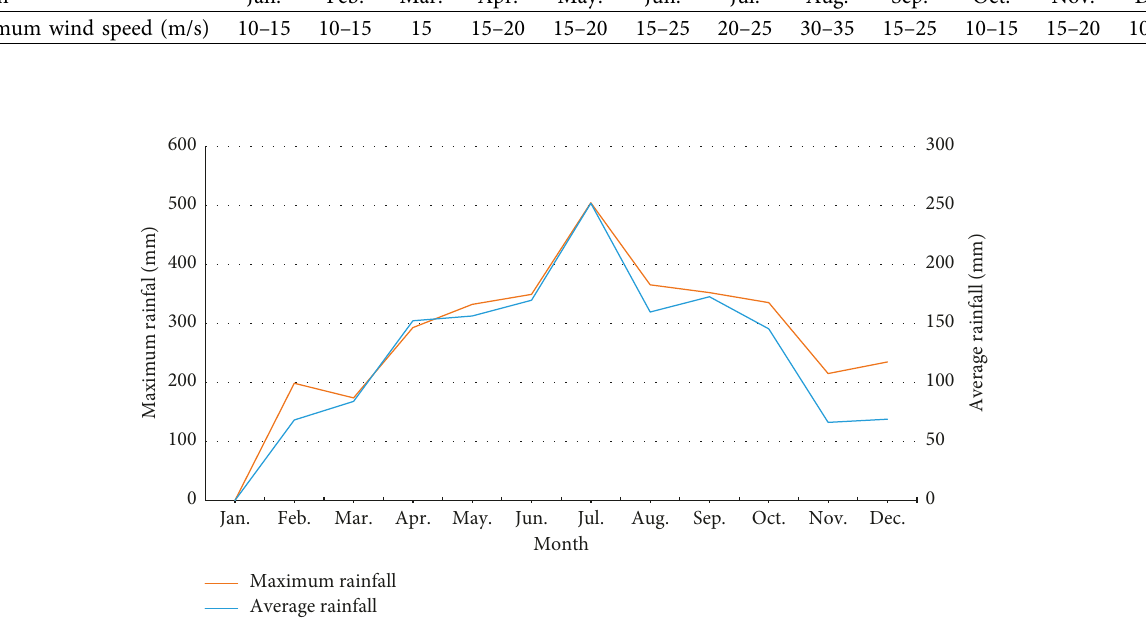
Figure 9: The monthly average rainfall and maximum rainfall of Wenli freeway.